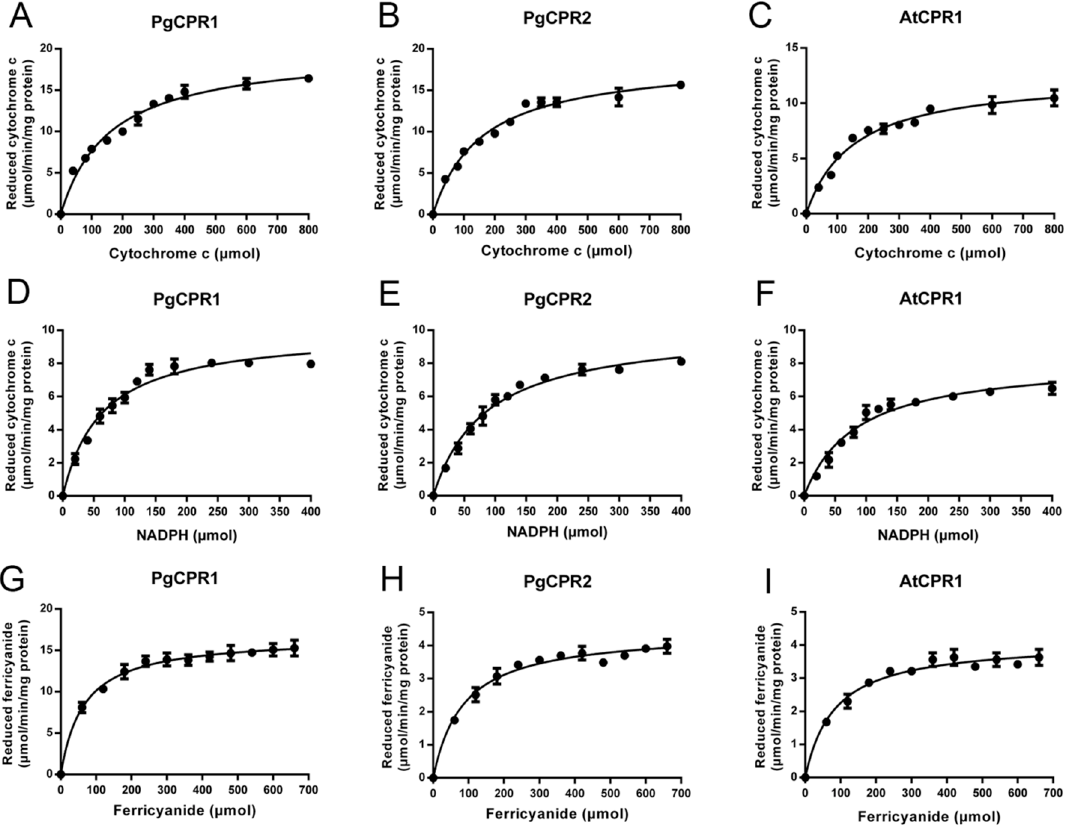
Figure 4. Kinetic parameters of the recombinant protein. ( A – C ), the kinetic parameters of recombinant protein to cytochrome c were measured by 550 nm absorbance increase method; ( D – F ), the kinetic parameters of NADPH were measured by cytochrome reduction method; ( G – I ) the kinetic parameters of K 3 Fe(CN) 6 were studied by 424 nm absorbance change method.